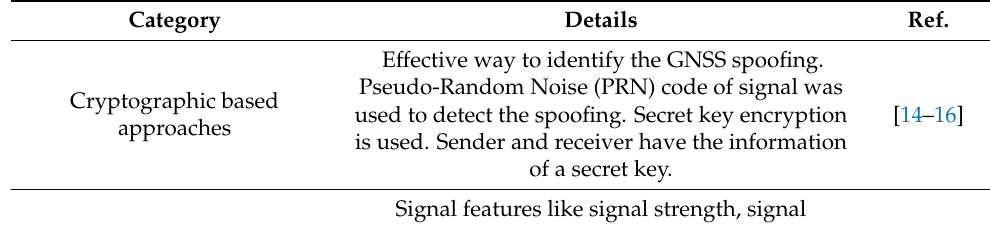
Table 2. Categories of GNSS Spoofing